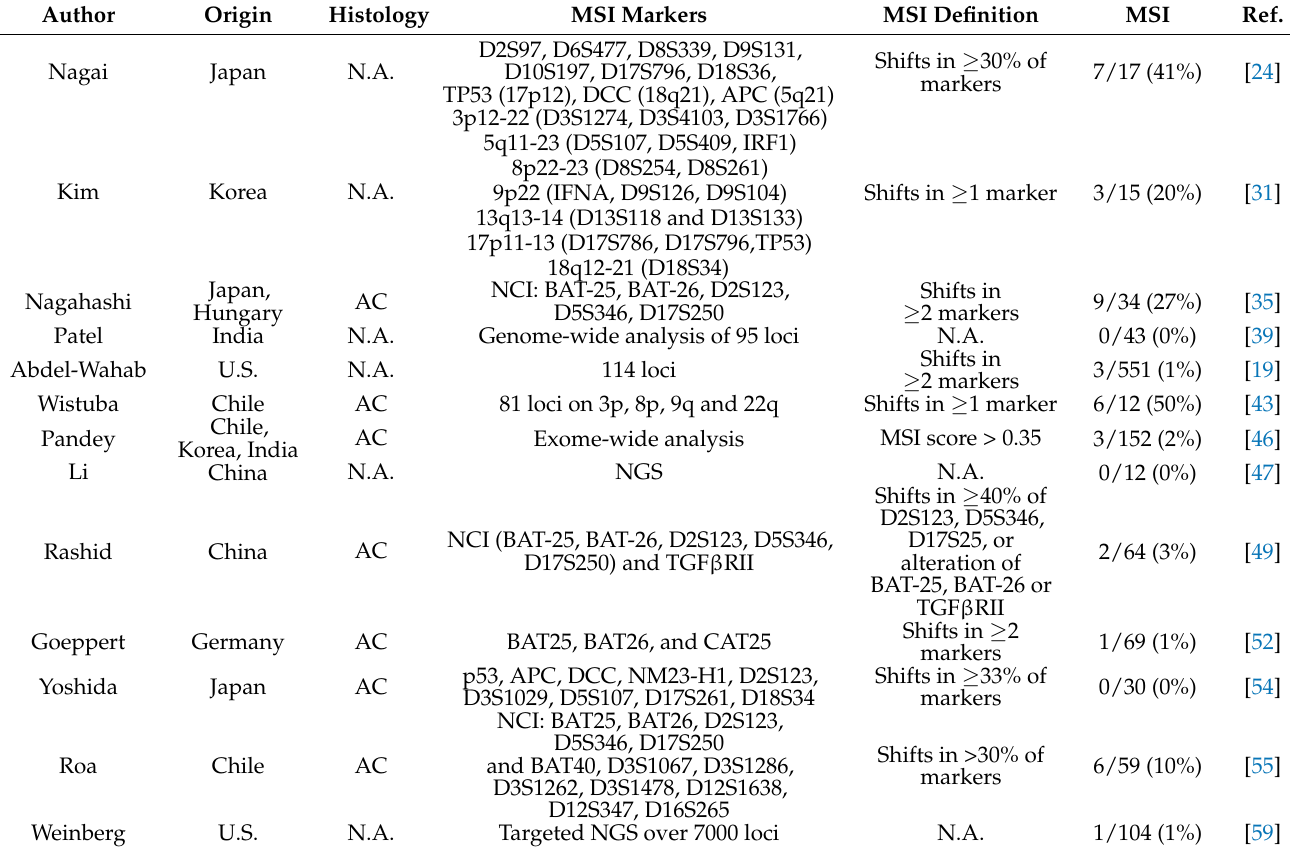
Table 3. Microsatellite instability in gallbladder